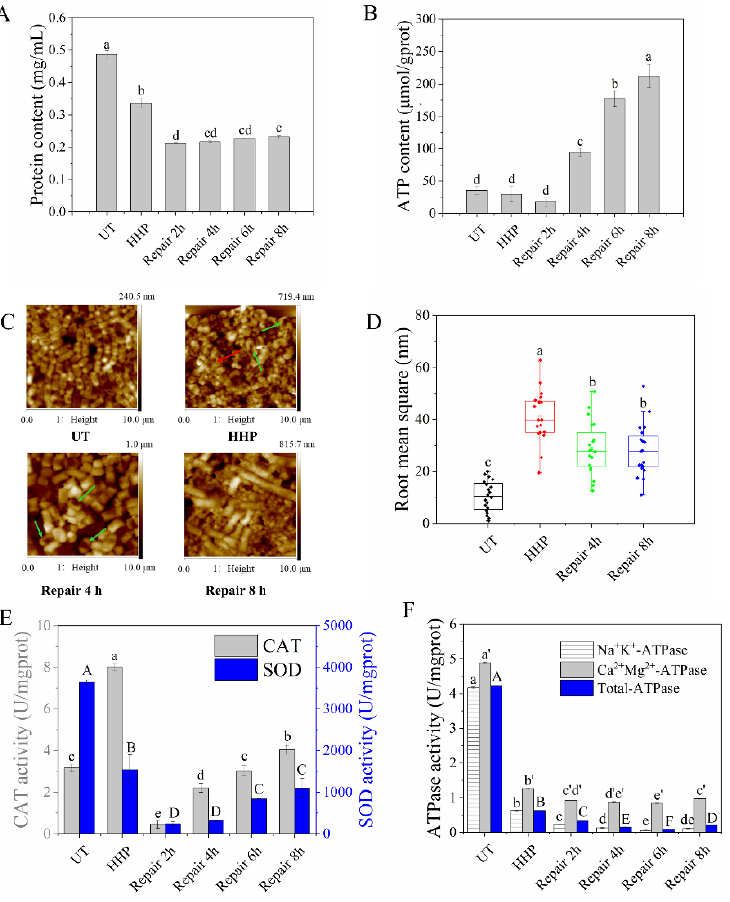
Figure 2. Effects of different repair times on intracellular protein content ( A ), intracellular ATP con- tent ( B ), AFM images ( C ), surface roughness ( D ), CAT and SOD activities ( E ), and ATPase activities ( F ). ( C ) contained the 2-dimensional and 3-dimensional AFM images of UT, HHP, and repair groups (repaired for 4 h and 8 h). The red arrow represented the cell fragments and the green arrows holes. The average bacterial surface roughness in nm was obtained on 509.6 × 509.6 nm 2 area of UT, HHP and repair groups. For each group, 20 cells were plotted randomly. Different letters (a to e, A to F, and a’ to e’) indicate statistically significance between different groups ( p ≤ 0.05, Duncan test).